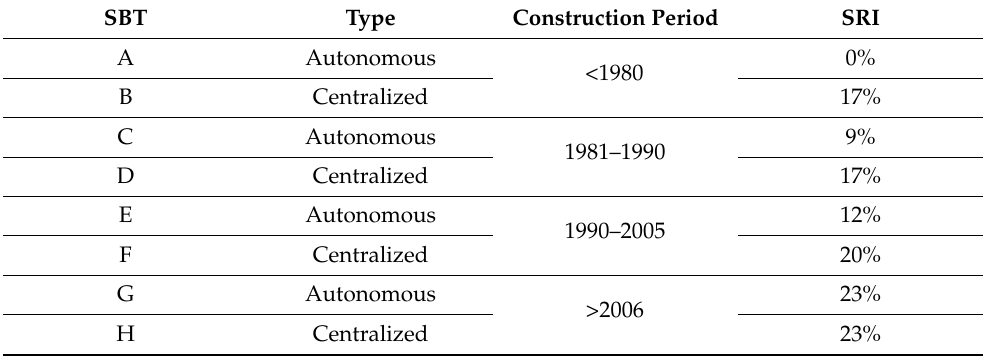
Table 6. SRI of the eight selected SBT (base scenario).